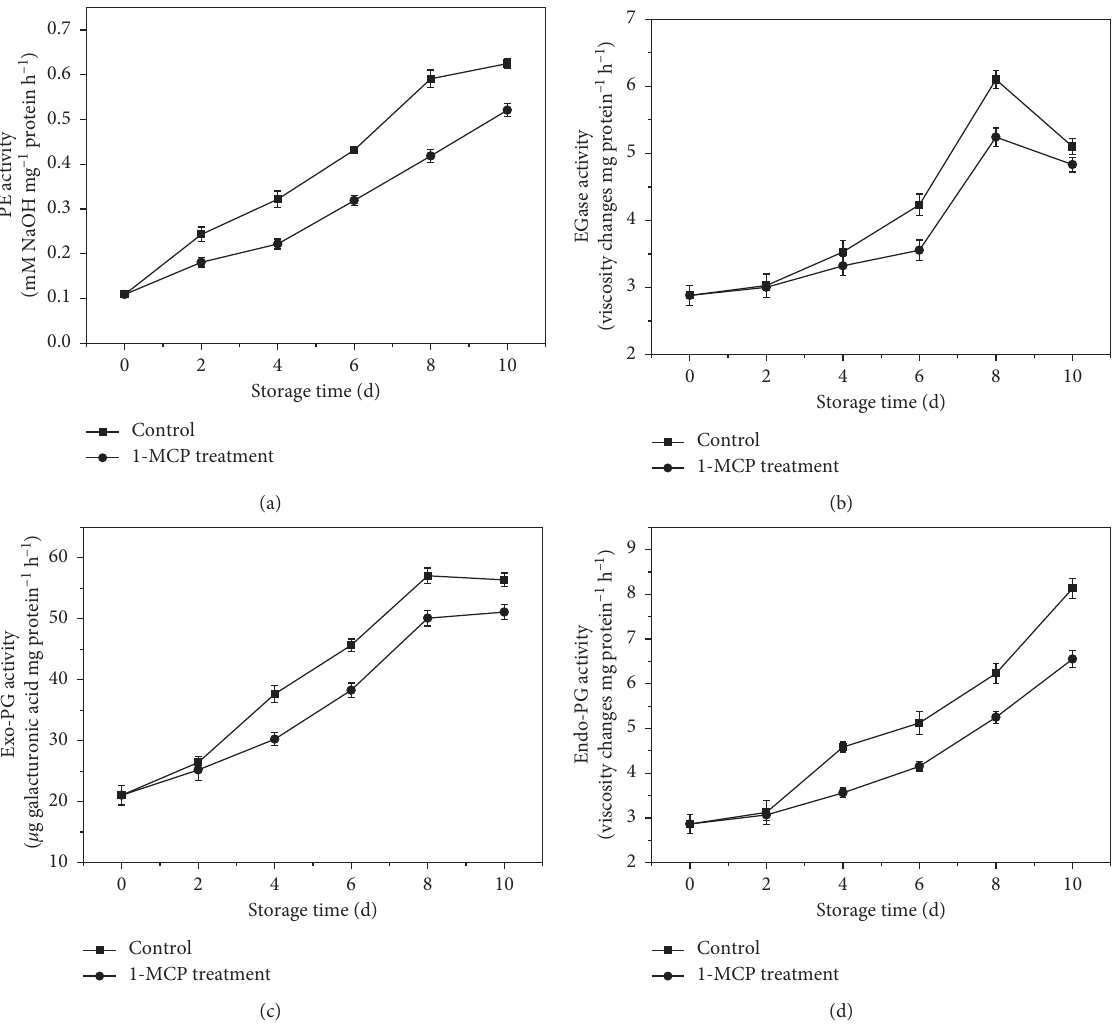
Figure 6: Effects of 1-MCP treatment on PE activity (a), EGase activity (b), exo-PG activity (c), and endo-PG activity (d) of mango fruit during storage at 25 ° C. The data are the means of triplicates ± standard